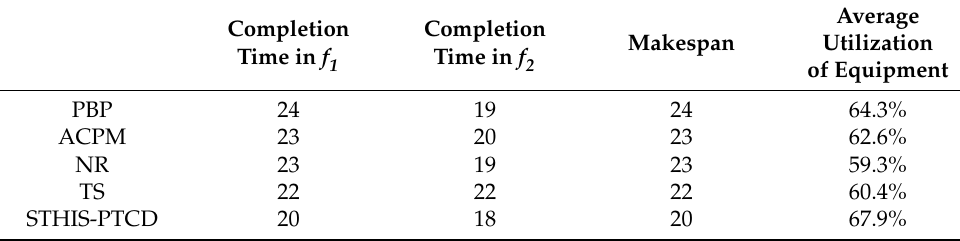
Figure 24. Gantt chart by the TS for workshop f 2 with 22 person-hours. Table 3. Statistics of integrated scheduling results between five algorithms of two workshops in completion time and average utilization of